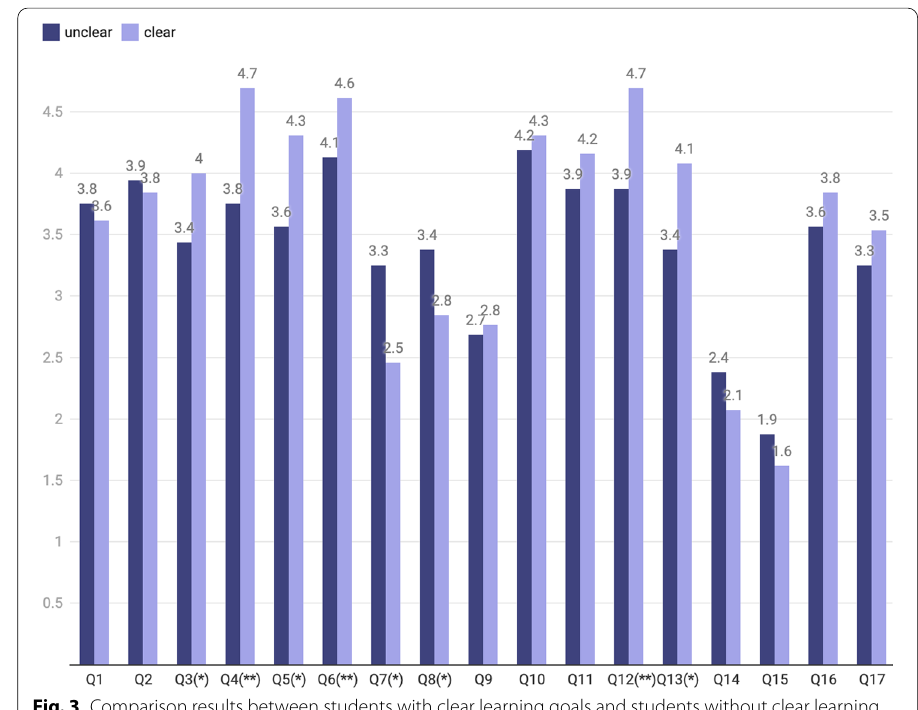
Fig. 3 Comparison results between students with clear learning goals and students without clear learning goals. (Significant Level (*) p < 0.1 , (**) p < 0.05